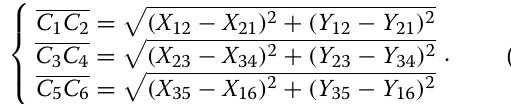
common tangent lines C 1 C 2 , C 3 C 4 , and C 5 C 6